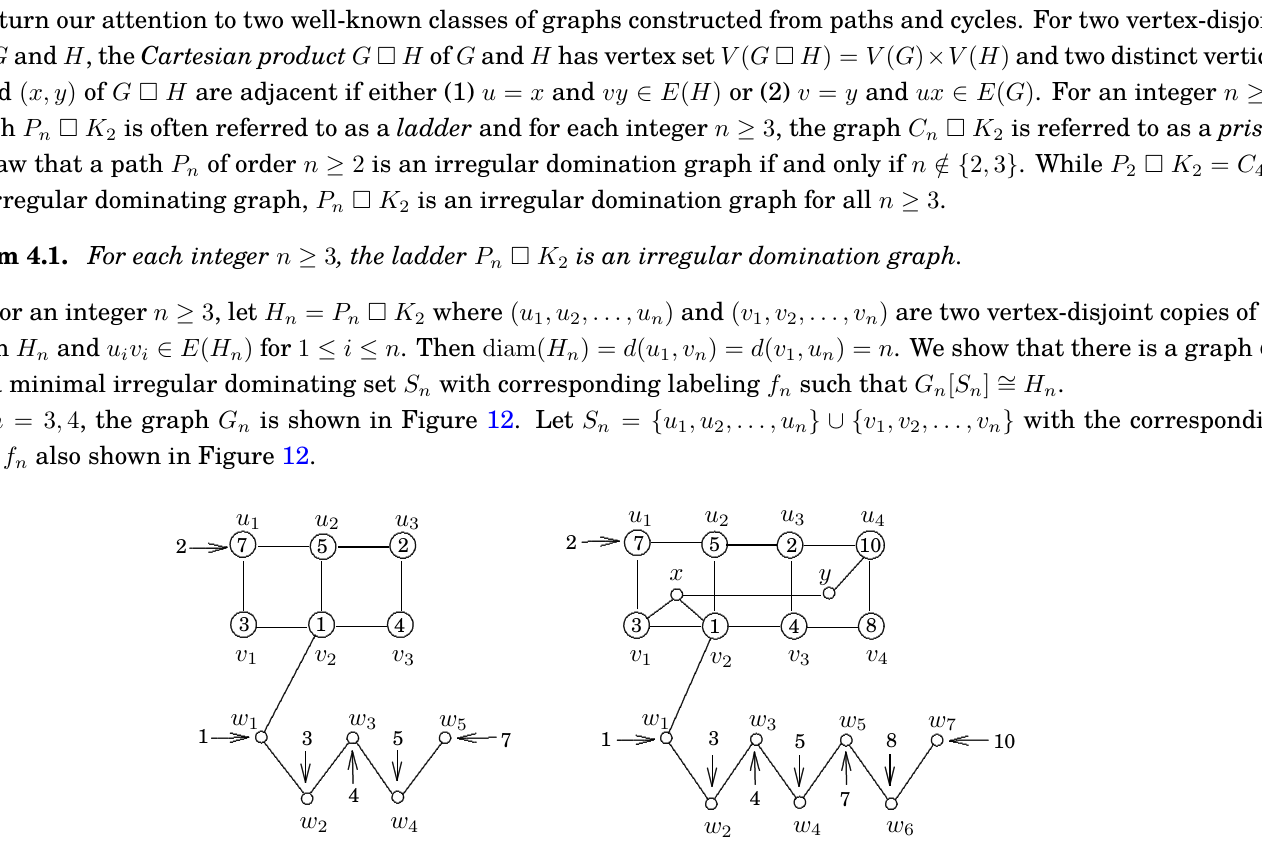
and G in the proof of Theorem 3 4